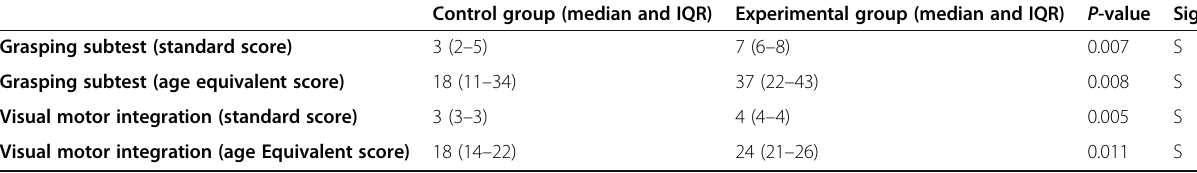
Table 4 Comparison of post-treatment results of experimental and control groups